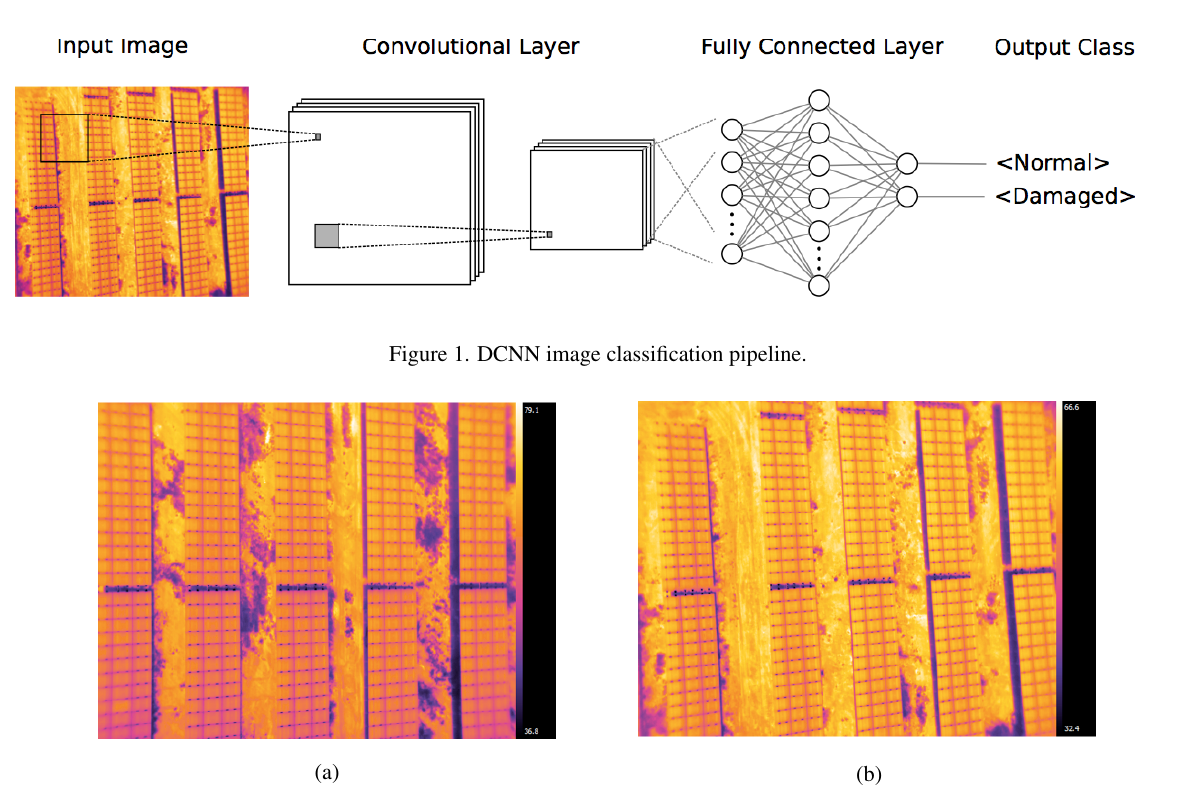
Figure 2. Figure 2a is an image with damaged photovoltaic cells. Figure 2b represents an image shown a normal photovoltaic